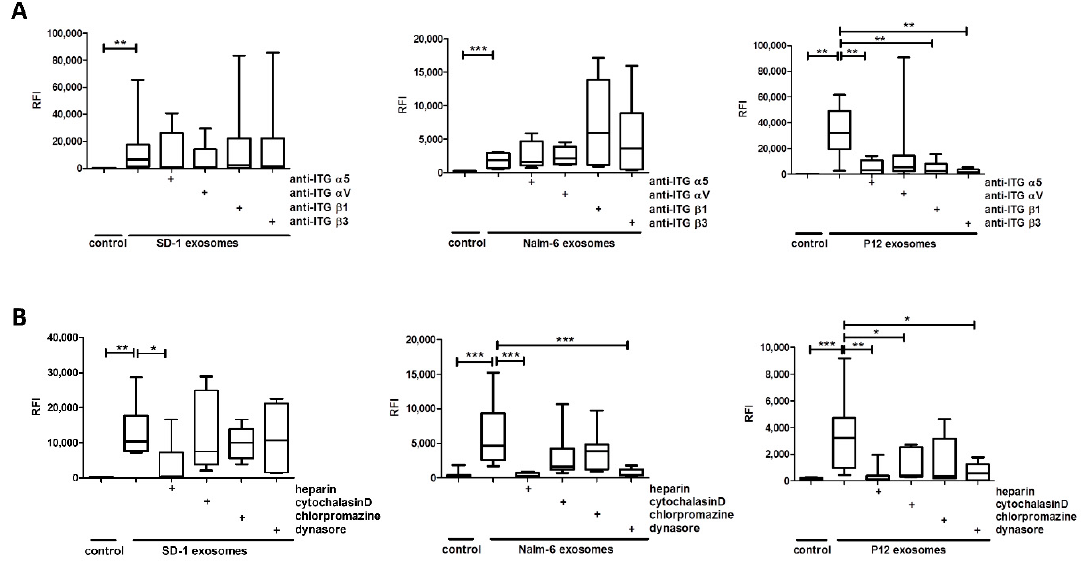
Figure 2. Mechanism of uptake / binding of acute lymphoblastic leukemia (ALL) cell-derived exosomes to blood-cerebrospinal fluid barrier (BCSFB) in vitro model. DiIC18(3) labeled exosomes (16 µ g per filter) were added onto the basolateral side of HiBCPP cells grown in inverted culture and incubated for 48 h. The nuclei were stained with DAPI solution. Relative fluorescence intensity (RFI) of exosomes was quantified by fluorescent microscopy (15 fields of view, 20 × objective). ( A ) Fluorescently labeled exosomes were pretreated with 4 µ g / mL anti-integrin-antibody (anti-ITG α 5; anti-ITG α V; anti-ITG β 1; anti-ITG β 3) for 30 min at 37 ◦ C before incubation on HiBCPP cells. ( B ) HiBCPP cells were pretreated with chemical inhibitors (10 µ g / mL heparin; 5 µ g / mL cytochalasin D; 50 µ M chlorpromazine; 80 µ M dynasore) for 1 h at 37 ◦ C before incubation. HiBCPP cells were washed with acidic PBS (pH = 2.5) after incubation to strip off adherend exosomes. Data shown are box plots with whiskers of at least 3 independent experiments performed in triplicates. * p < 0.05; ** p < 0.01; *** p < 0.001.